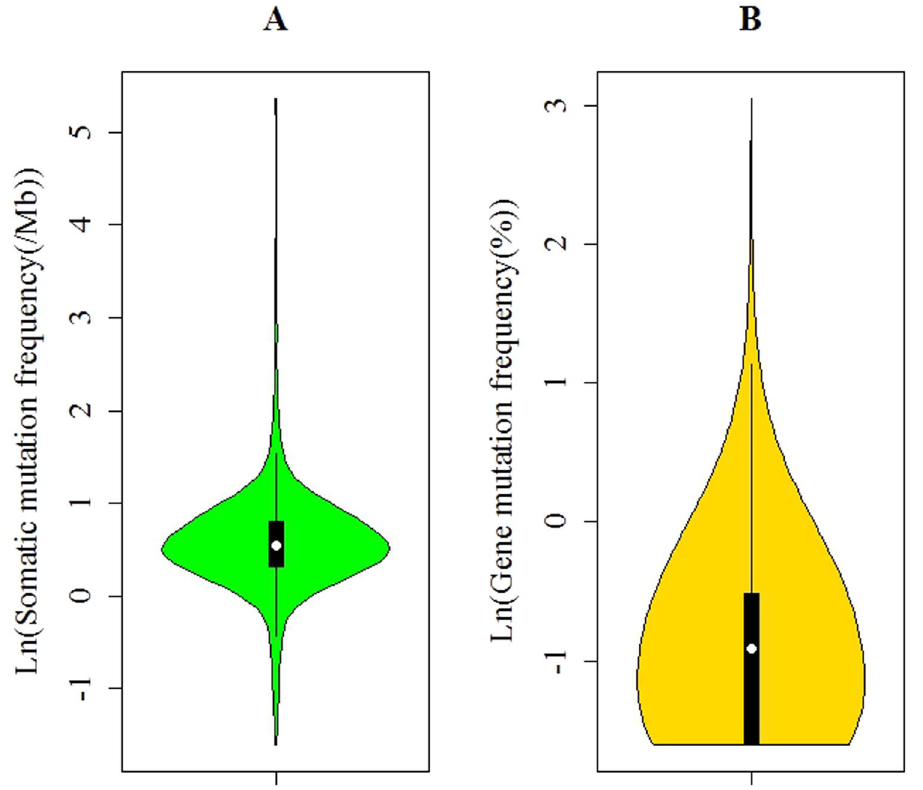
Figure 1. The violin plots for ( A ) the frequency of genes mutated per patient in the entire cohort and ( B ) the frequency of mutations per gene in the entire cohort. Figure 1A illustrated that the somatic mutation frequencies varied more than three orders of magnitude across different patients. Figure 1B illustrated that only a small number of genes mutated at high frequencies, most genes mutated at intermediate or low frequencies.